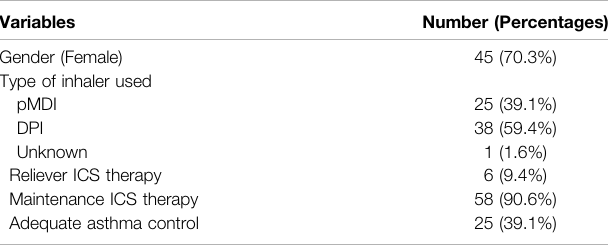
TABLE2| Demographiccharacteristicsoftheincludedstudyparticipants(n (cid:1) 64).